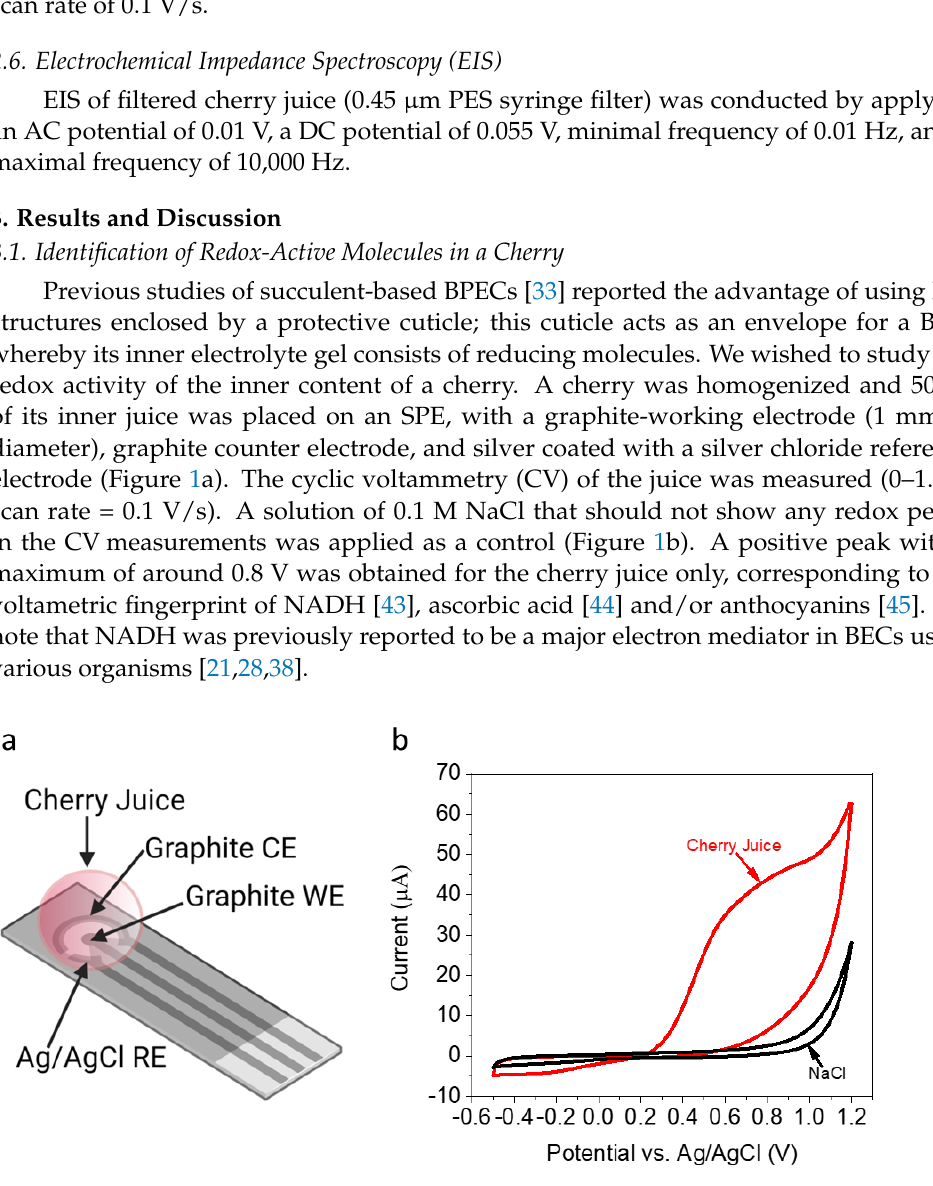
Figure 1. Identification of redox-active molecules in a cherry. A cherry was homogenized and 50 µL of its internal solution was placed on a SPE. CV of the solution and 0.1 M NaCl (as a control) was measured (0 – 1.2 V, scan rate = 0.1 V/s). ( a ) Schematic description of the system consisted of SPE with graphite-working and counter electrodes (WE and CE respectively), and Ag coated with an AgCl Reference electrode (RE). A drop of collected cherry juice was placed on top of the electrodes. ( b ) CV of 0.1 M NaCl (black) and cherry juice (red).